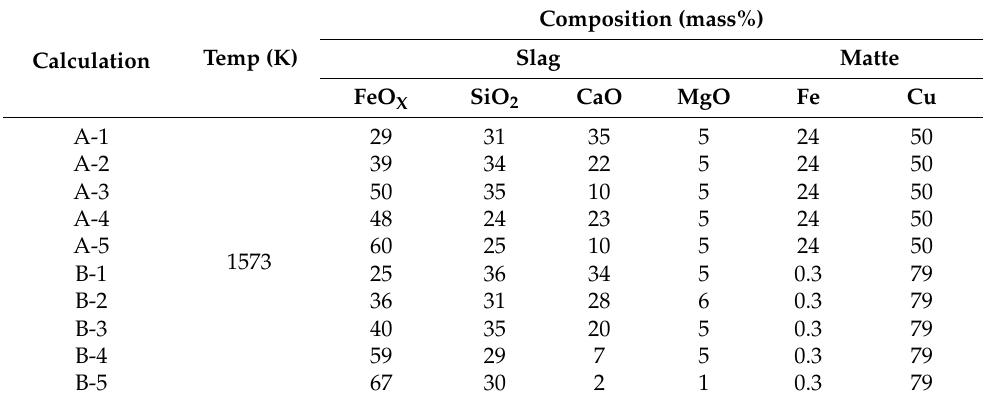
Table 4. Simulation conditions of the slag and matte as a function of the change in Fe and Cu content in the matte and slag compositions.